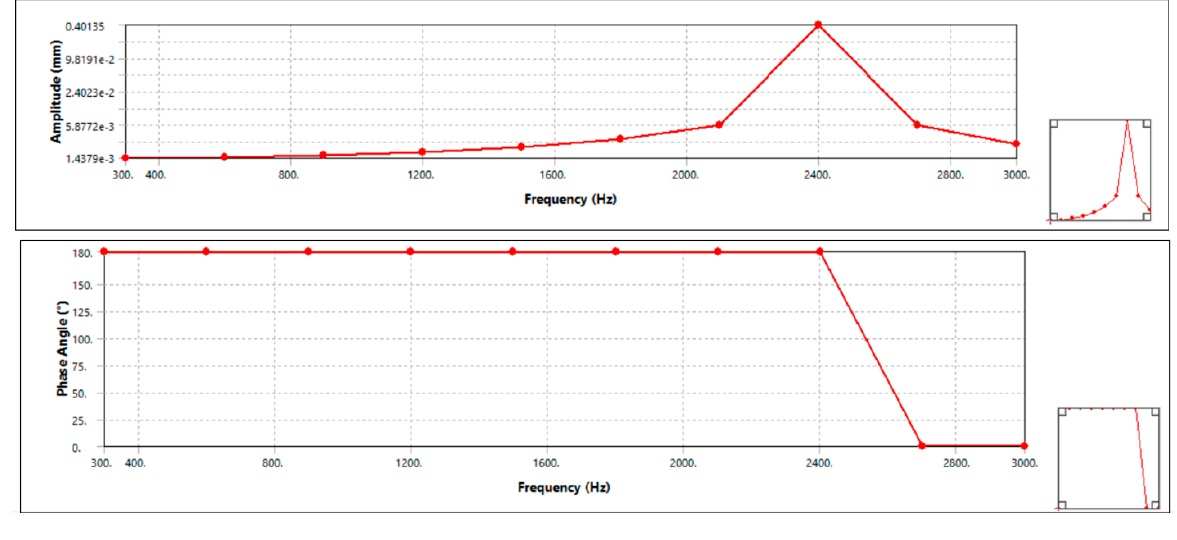
Figure 8. Harmonic response of aluminum alloy disc.